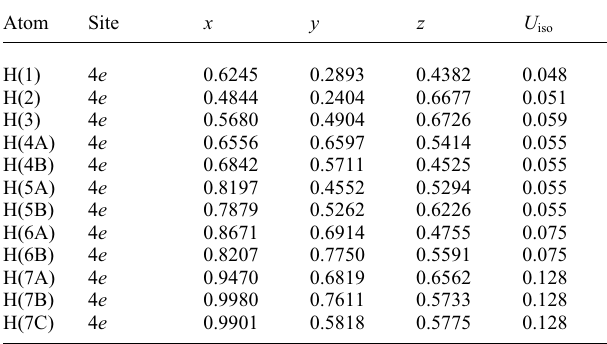
Table 2. Atomic coordinates and displacement parameters (in Å 2 )